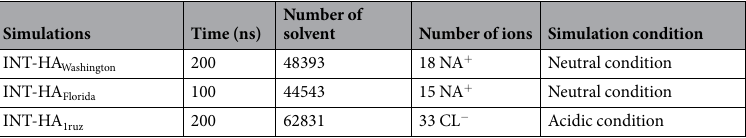
Table 1. Molecular